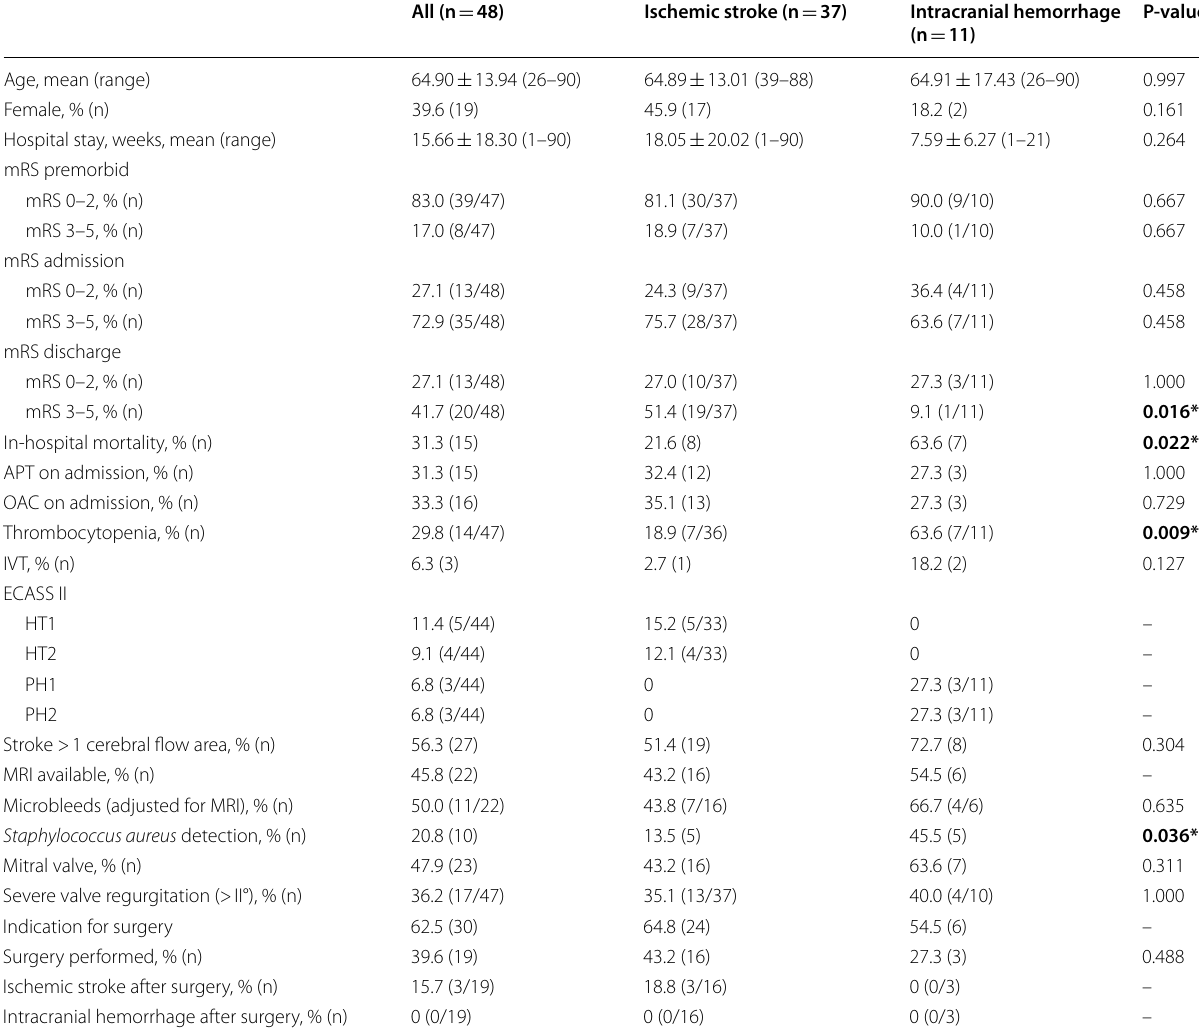
Table 2 Baseline characteristics, all